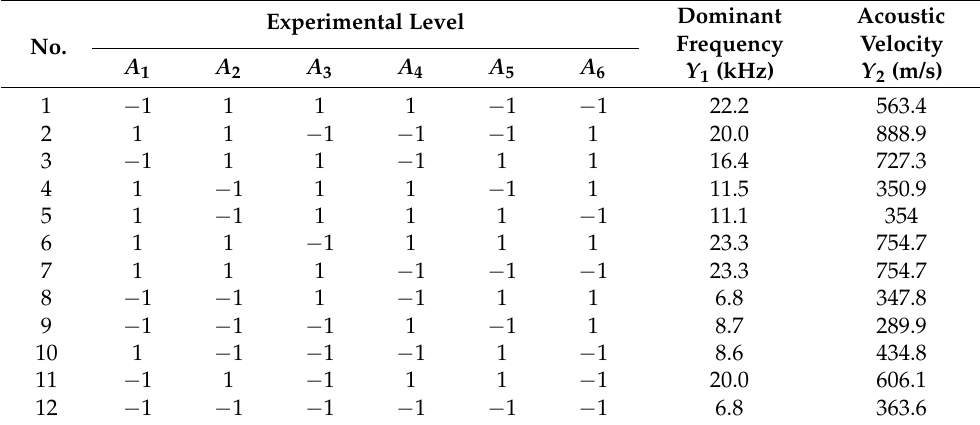
Table 5. Design and results of Plackett—Burman experiments.